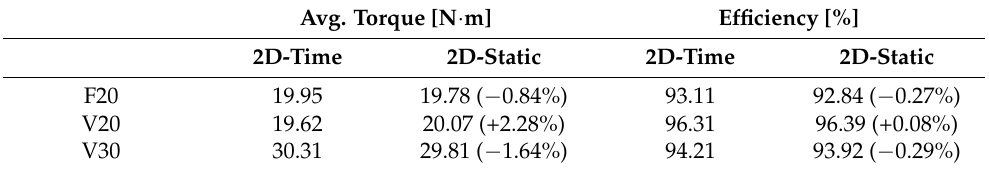
Figure 19. Instantaneous torque considering i d = 0 of selected geometries: F20, V20, and V30. Table 4. Average torque and efficiency obtained from 2D stationary model and 2D time-dependent model.